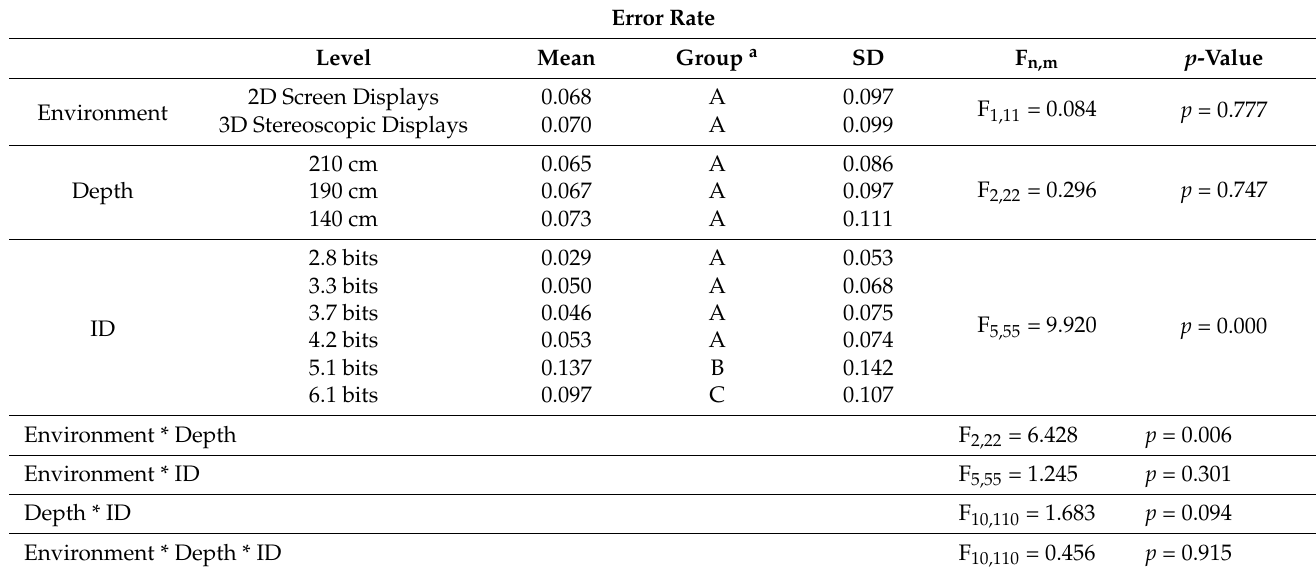
Table 12. Means, SDs, ANOVA, and Tukey HSD test results of index of error rate.